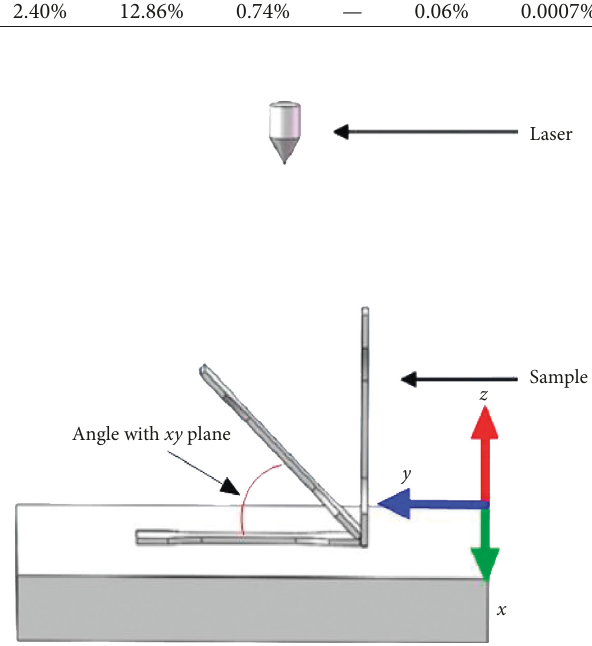
Figure 2: Angle with the xy plane.